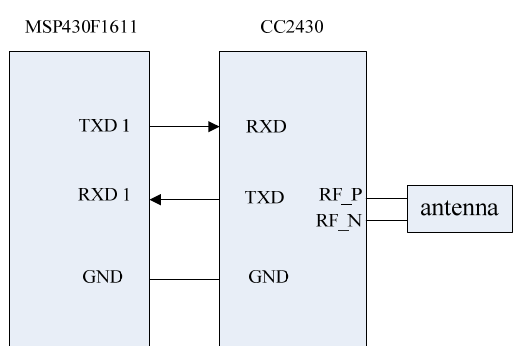
Figure 11. Interface circuit of the ZigBee